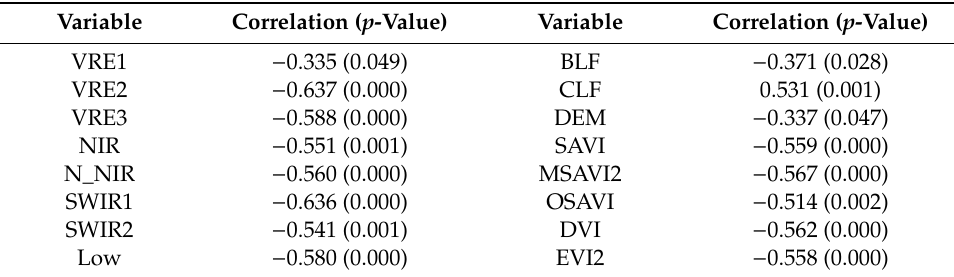
Table 6. Variables significantly correlated with coniferous forest biomass.